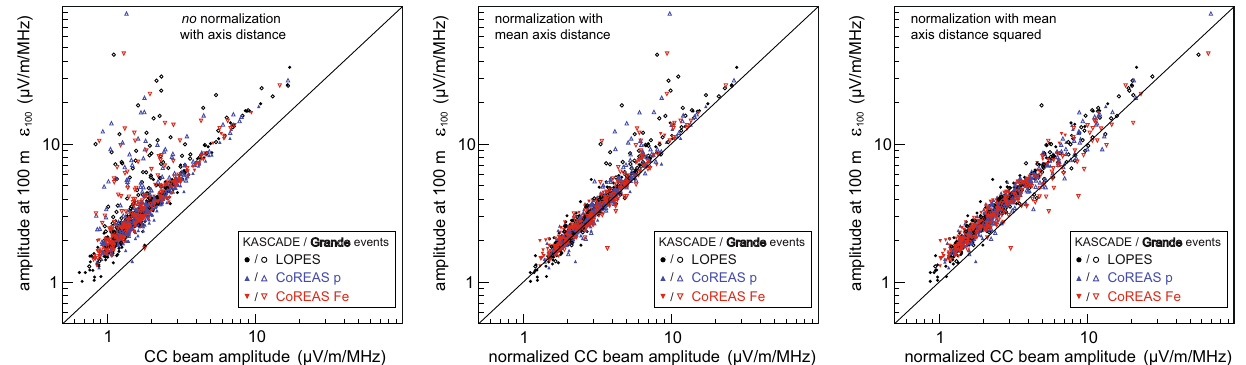
Fig. 14 Event-by-event comparison of the amplitude at 100m axis distance and the amplitude of the cross-correlation beam. While for KASCADE events there always is a good correlation, this is not the case for several Grande events (outliers in left and middle plots are